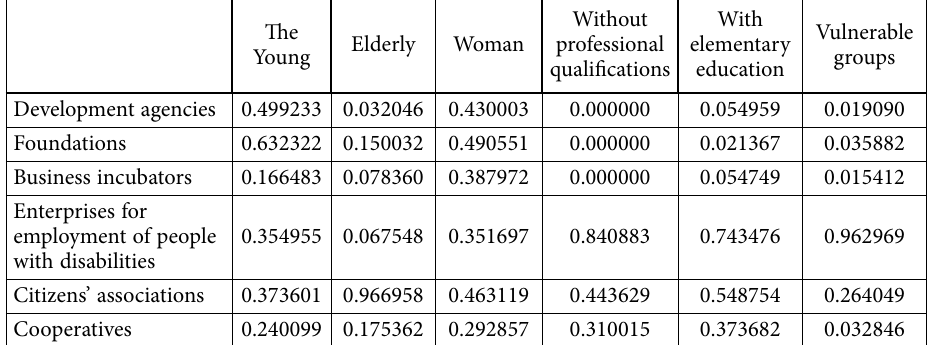
Table A1. Normalized decision matrix